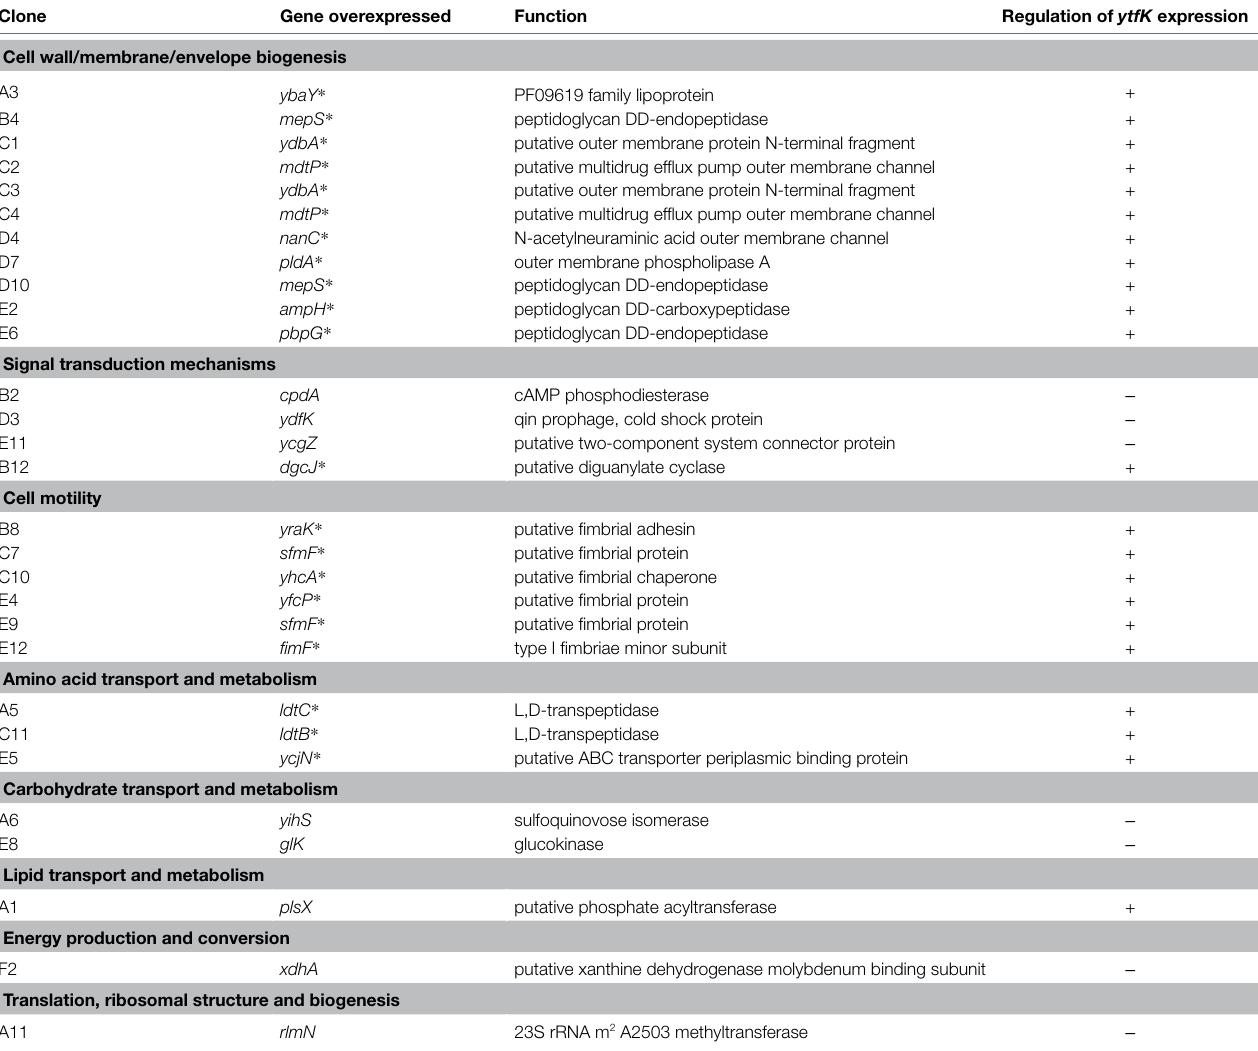
TABLE 1 | Genes identified by overexpressing each E. coli gene from the ASKA library (Kitagawa et al., 2005) and by screening for the impaired regulation of translational fusion ( ytfK TL P1 + P2).